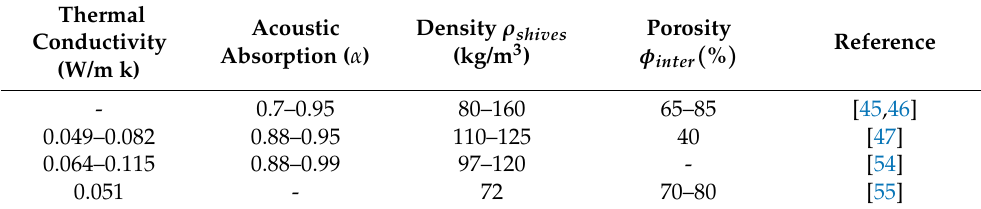
Table 2. Properties of hemp